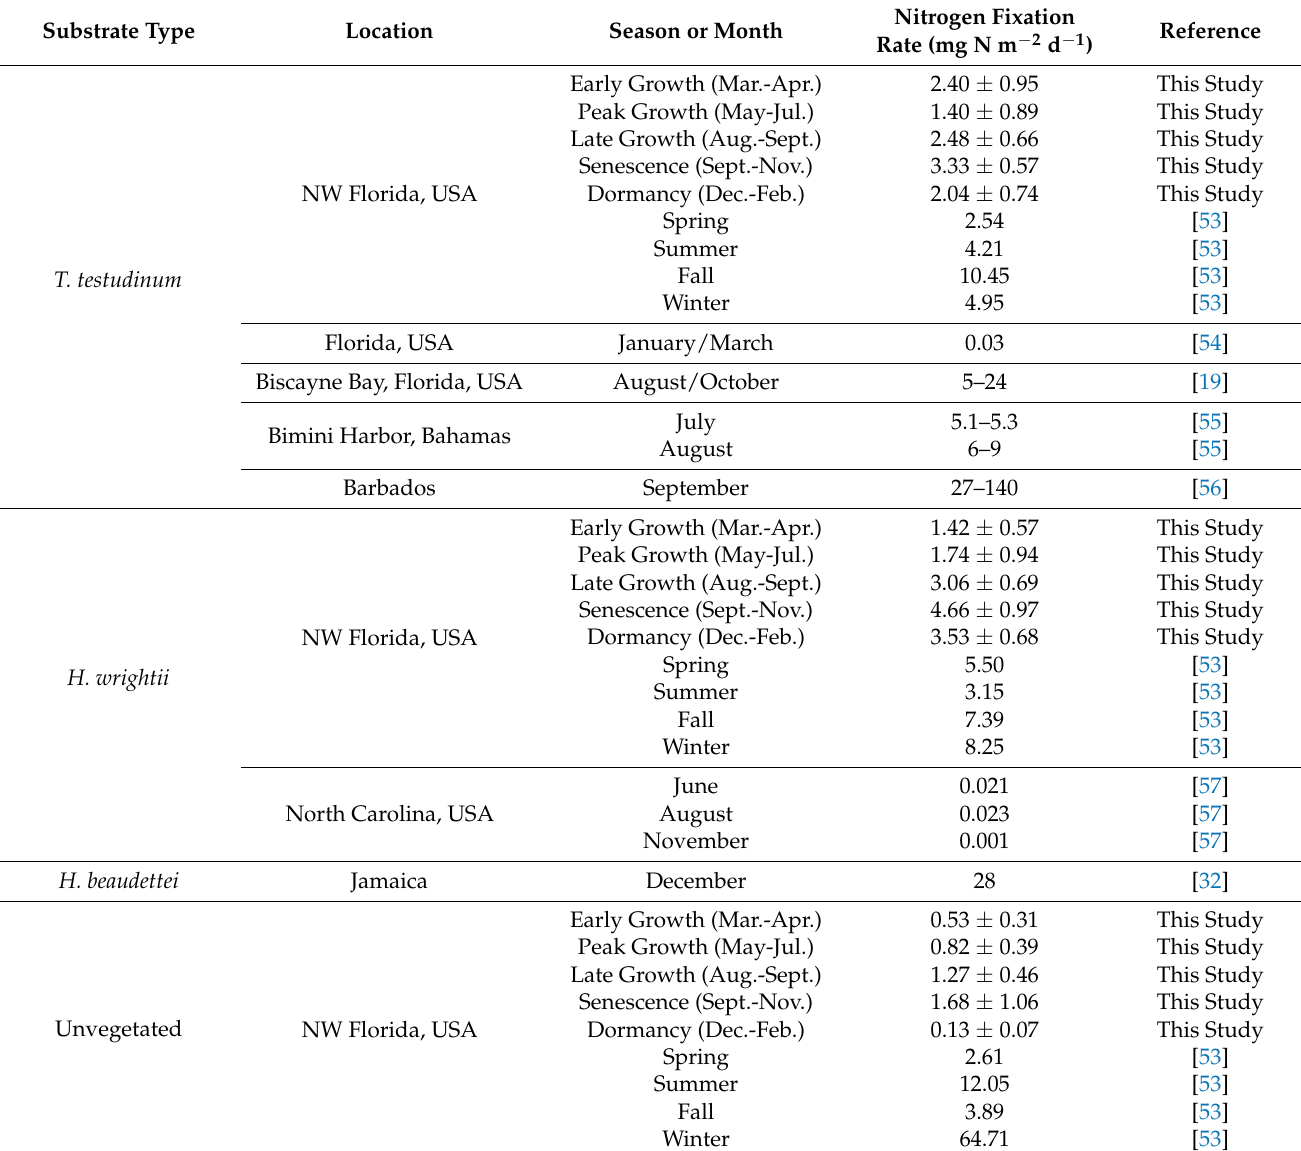
Table 2. Nitrogen fixation rates from this study compared to other studies.